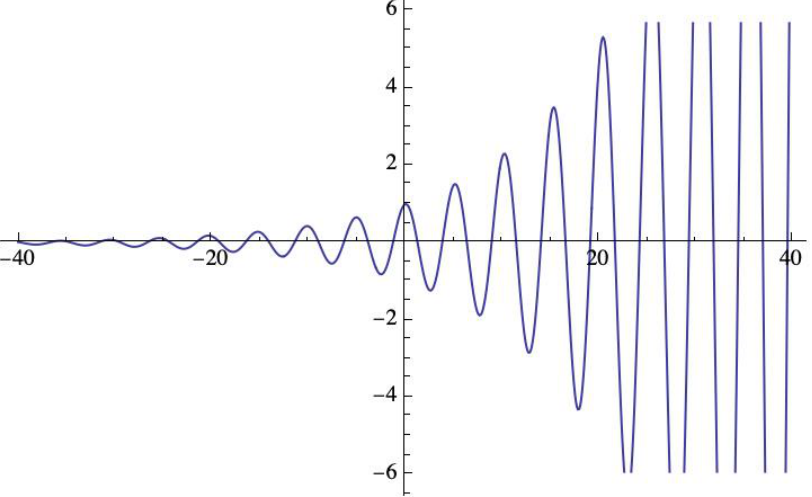
Figure 1. Mathematica plot of Re ( u 2 ) with a = 1, A = − 3, c =